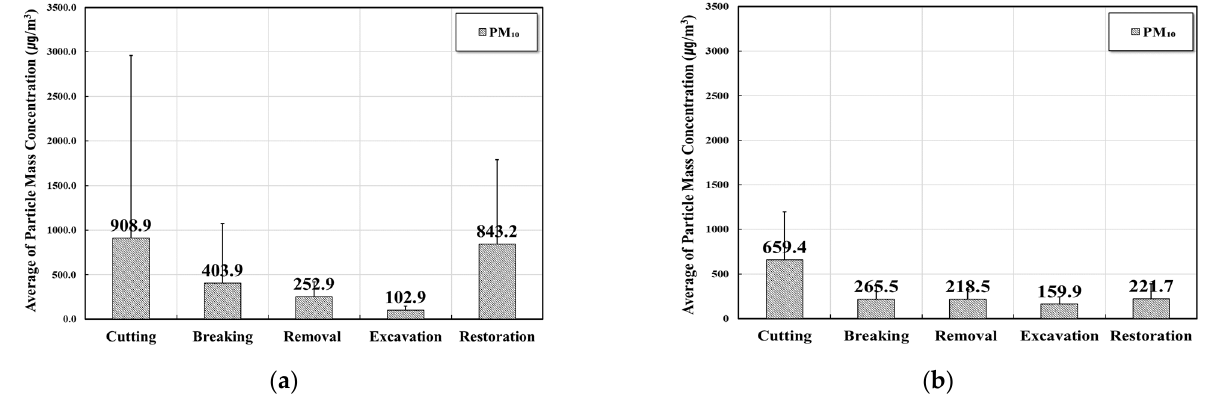
Figure 4. PMC for all excavation–restoration work processes: ( a ) First and ( b ) second field test out- comes.